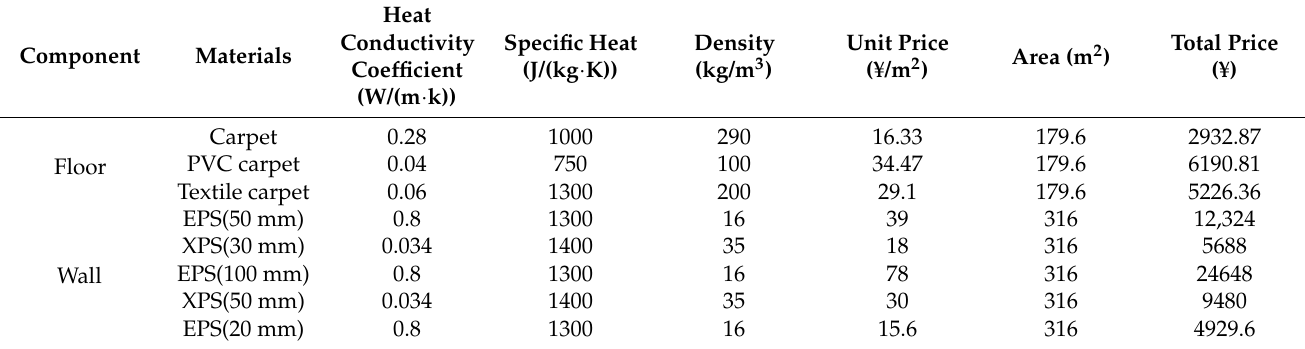
Table 6. Physical parameters and prices of wall insulation and carpet materials.